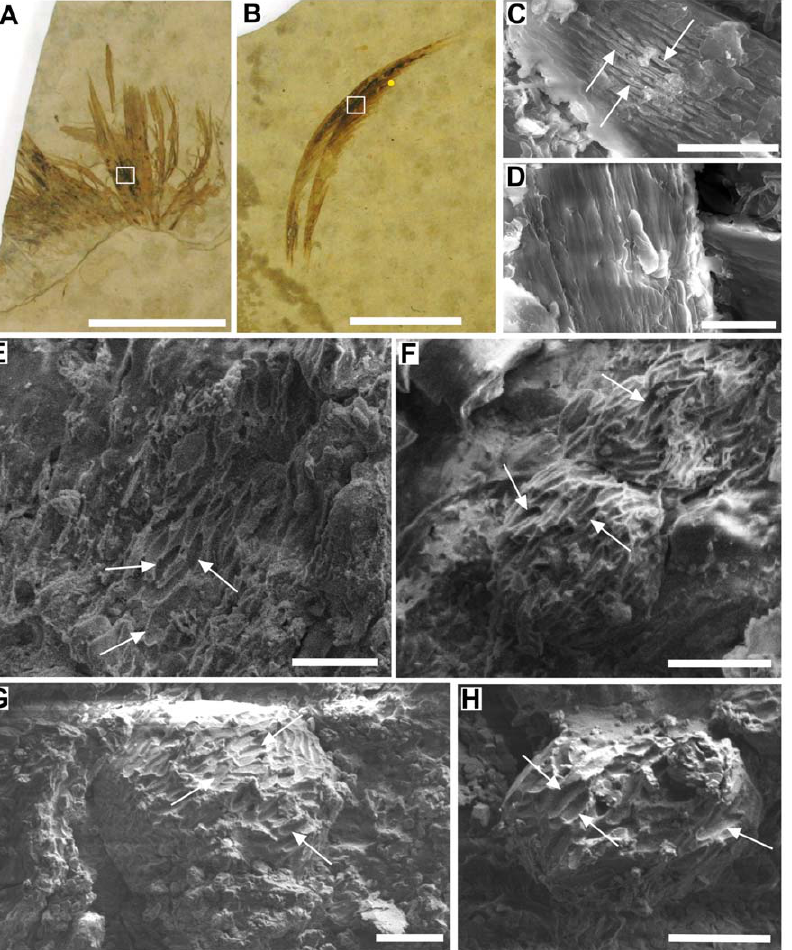
Figure 1. Visual and SEM images showing the presence of melanosomes in Gansusyumenensis and extant feathers. Isolated feathers (A) MGSF318 and (B) MGSF317, with SEM images of the fractured surfaces of (C) an extant Marabou stork feather and (D) a White-naped Crane feather, and the dark areas of MGSF317 (E-F) and MGSF318 (G-H). Eumelanosomes present within the extant Marabou stork feather (C) and the elongate mouldic structures interpreted as eumelanosomes in the fossil feathers (E-H) are highlighted with white arrows. Scale bars represent 2 cm (A-B), 5 m m (C–D) and 2 m m (E–H). The fossil feather SEM images were taken from the areas indicated by the white boxes, and the yellow dot in (B) represents the approximate area where the FTIR map discussed below is taken